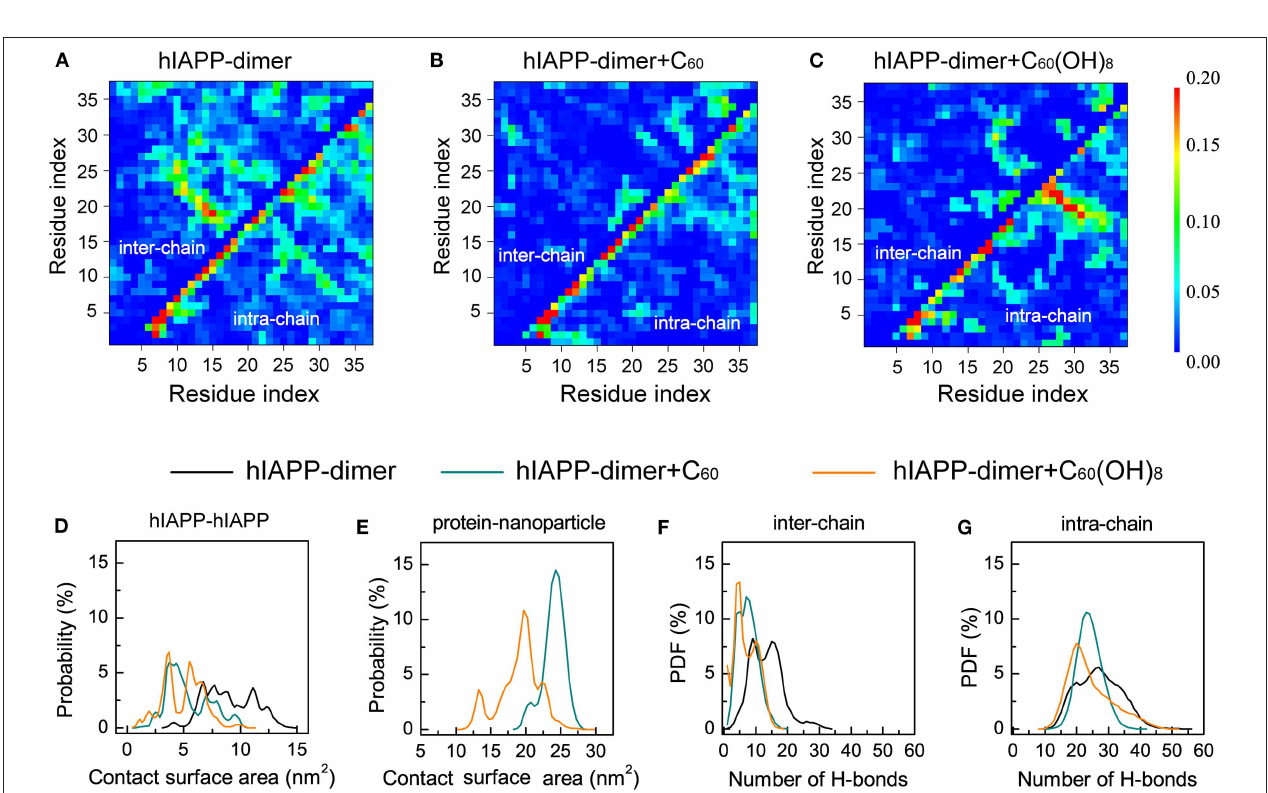
FIGURE 3 | Analysis of the effects of C 60 /C 60 (OH) 8 on the hIAPP interactions. Inter- and intra-peptide MC-MC contact probability maps for hIAPP dimer in the three different systems, hIAPP-dimer (A) , hIAPP-dimer + C 60 (B) , and hIAPP-dimer + C 60 (OH) 8 (C) . PDF of protein–protein (D) and protein–nanoparticle (E) contact surface area (CSA). PDF of inter-chain (F) and intra-chain (G) H-bond number.